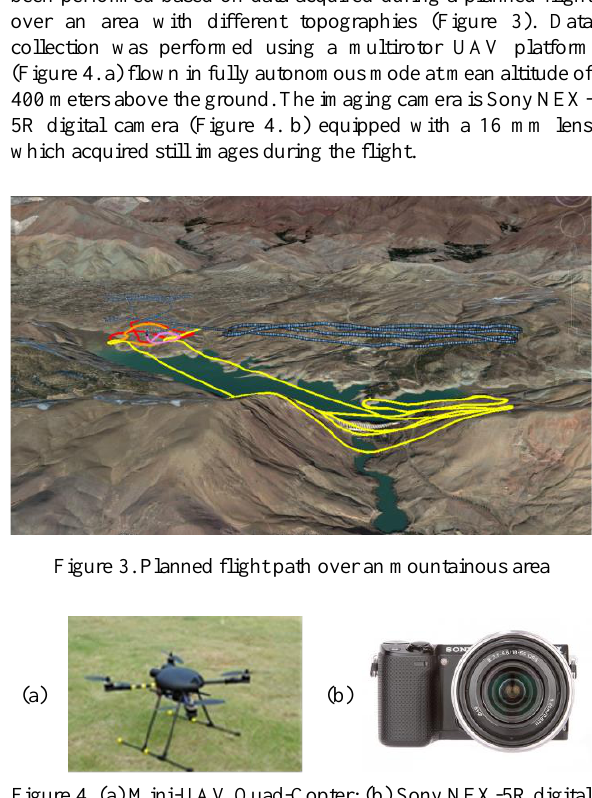
Figure 4. (a) Mini-UAV Quad-Copter; (b) Sony NEX-5R digital